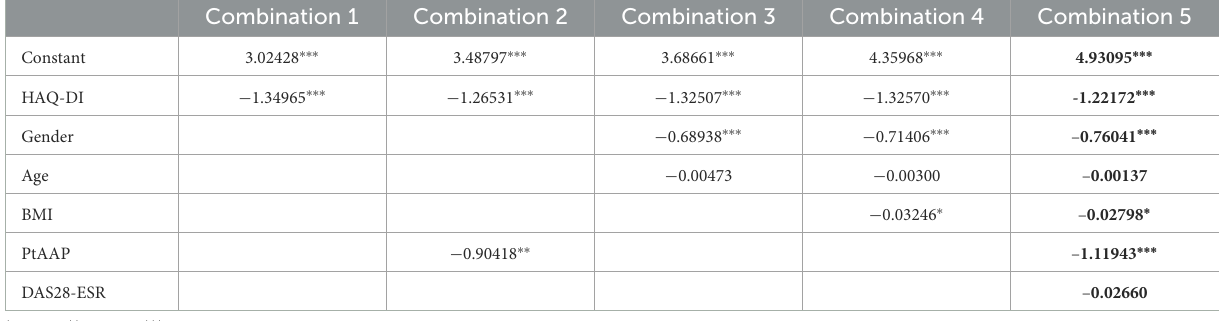
TABLE 4 The parameters of mapping algorithm from EQ-5D-5L to HAQ-DI based on